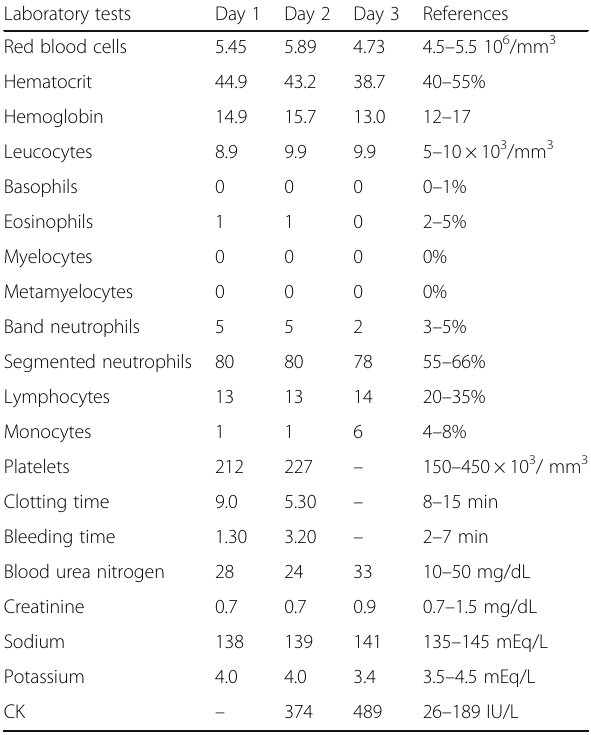
Table 1 Results of laboratory tests carried out